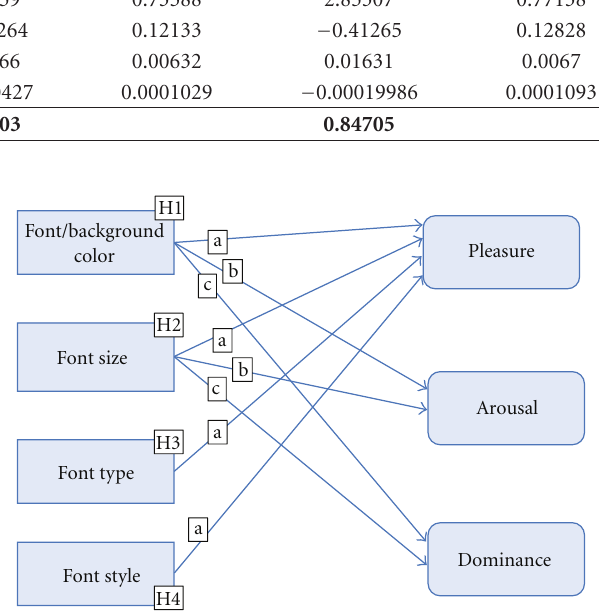
Figure 5: The proposed model for the relations between the inde- pendent variables on the three emotional dimensions “Pleasure”, “Arousal”, and